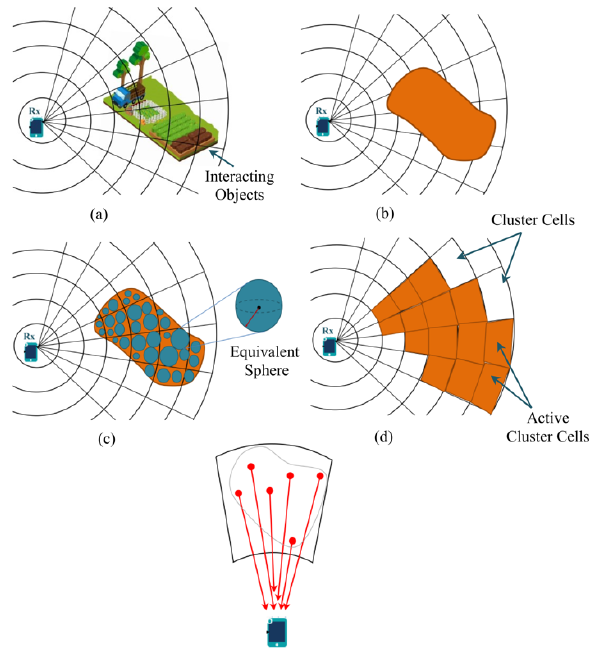
Figure 3. The process of modeling objects in stochastic mode, a) Real interacting objects (IOs), b) Cross section of the overall area, c) Modeling the IOs with equivalent spheres, d) Active clusters, e) MPCs produced in an active cluster cell. Table II. Some proposed random distributions for channel